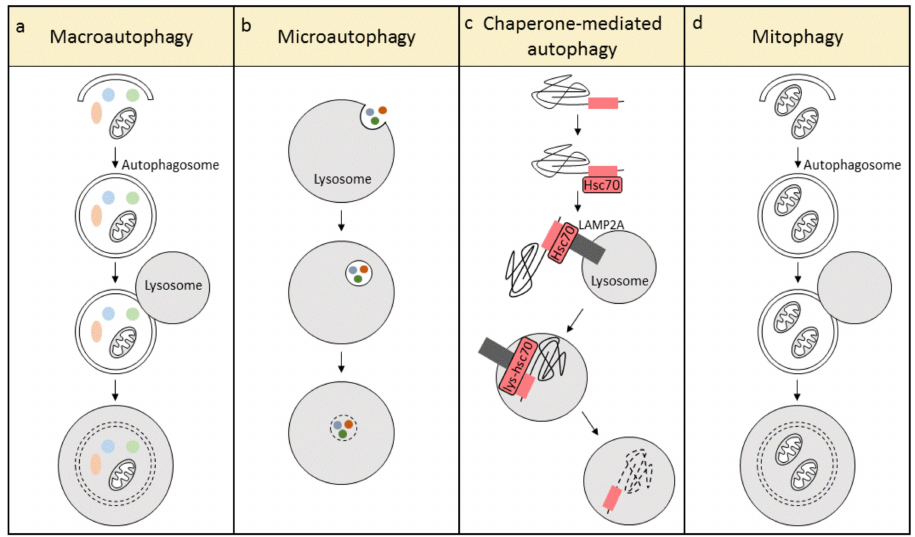
Figure 1. The three different types of autophagy: ( a ) macroautophagy, ( b ) microautophagy, and ( c ) chaperone-mediated autophagy. Mitophagy ( d ) is a specialized form of macroautophagy, which selectively degrades